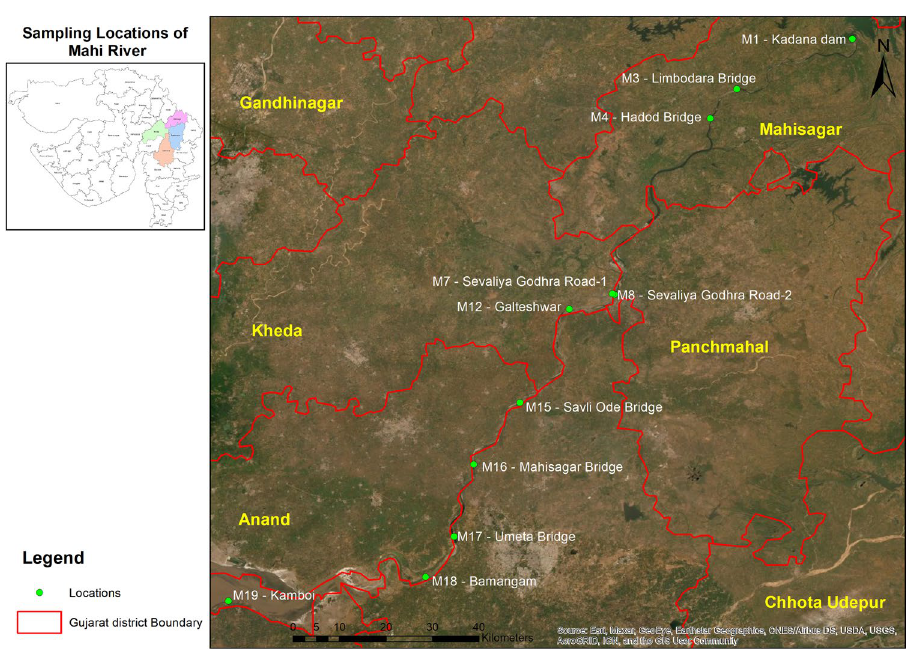
Fig. 1 Sampling locations